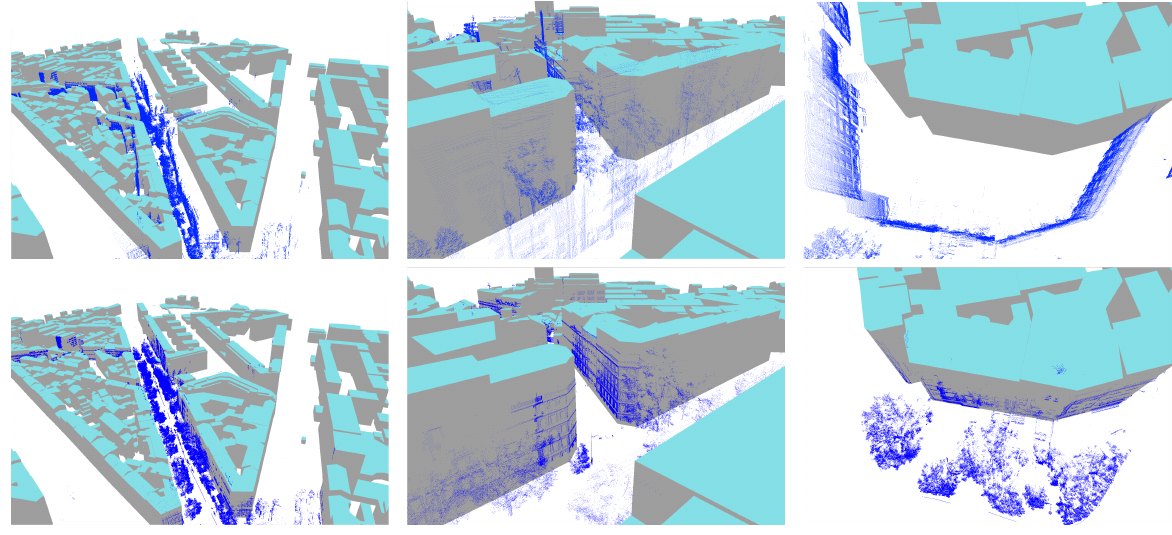
Figure 9: Initial (top) and final (bottom) steps of the registration of an artificially degraded terrestrial laser point cloud with around 20 meters precision on three different area of